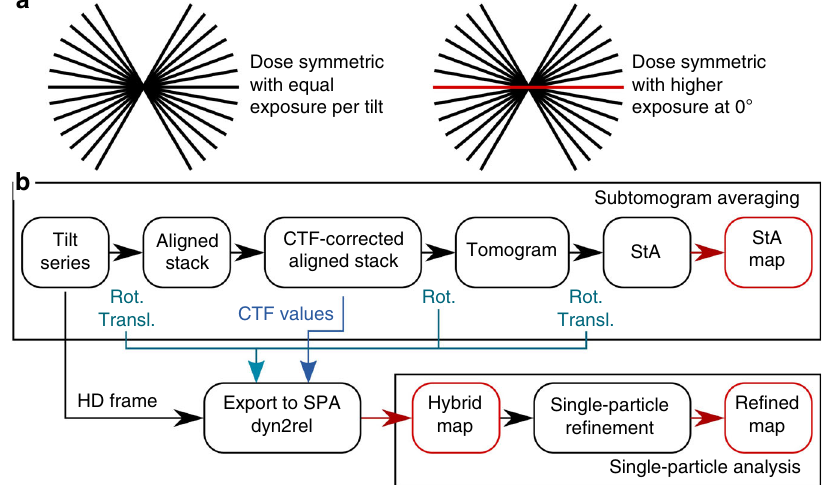
Fig. 1 Scheme of the Hybrid StA-SPA work fl ow. a A schematic depicting the distribution of dose in the dose-symmetric scheme 20 with uniform dose distribution (left) and with an increased exposure for the untilted image shown in red (right panel). b Data fl ow diagram for conventional and hybrid StA, black boxes correspond to the intermediate steps, red boxes indicate the output maps, blue arrows indicate geometric transforms performed between the processing steps and the CTF information which are exported for hybrid StA processing.